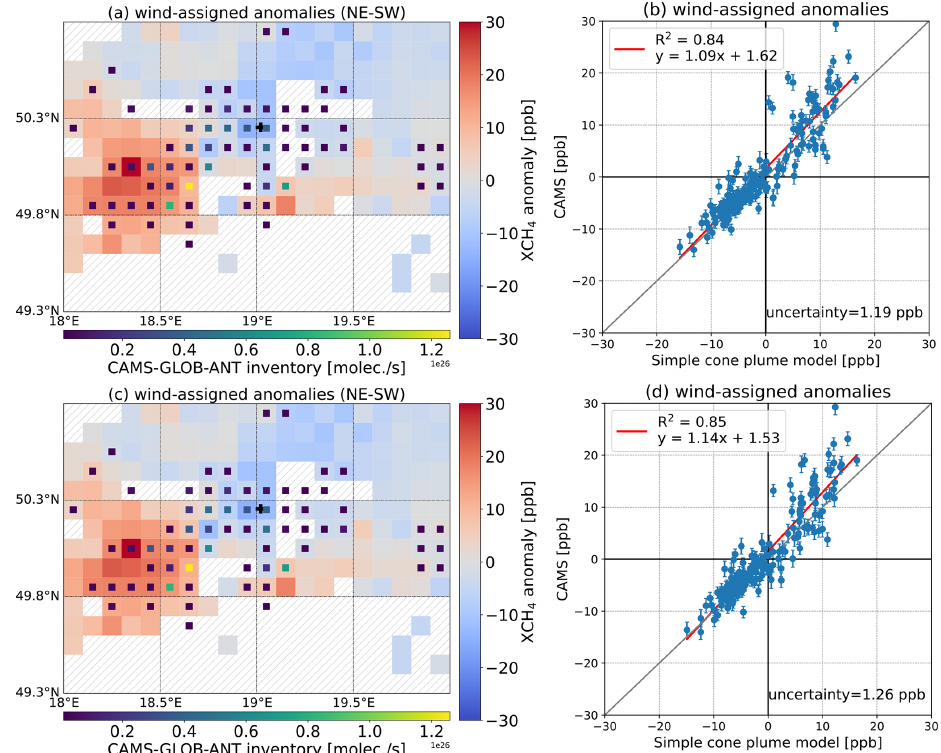
Figure 11. Similar figures to Fig. 5b–c. Results are derived from CAMS XCH 4 , CAMS emission inventory, and ERA5 wind at 330m for (a) – (b) α = 50 ◦ , and (c) – (d) α = 70 ◦